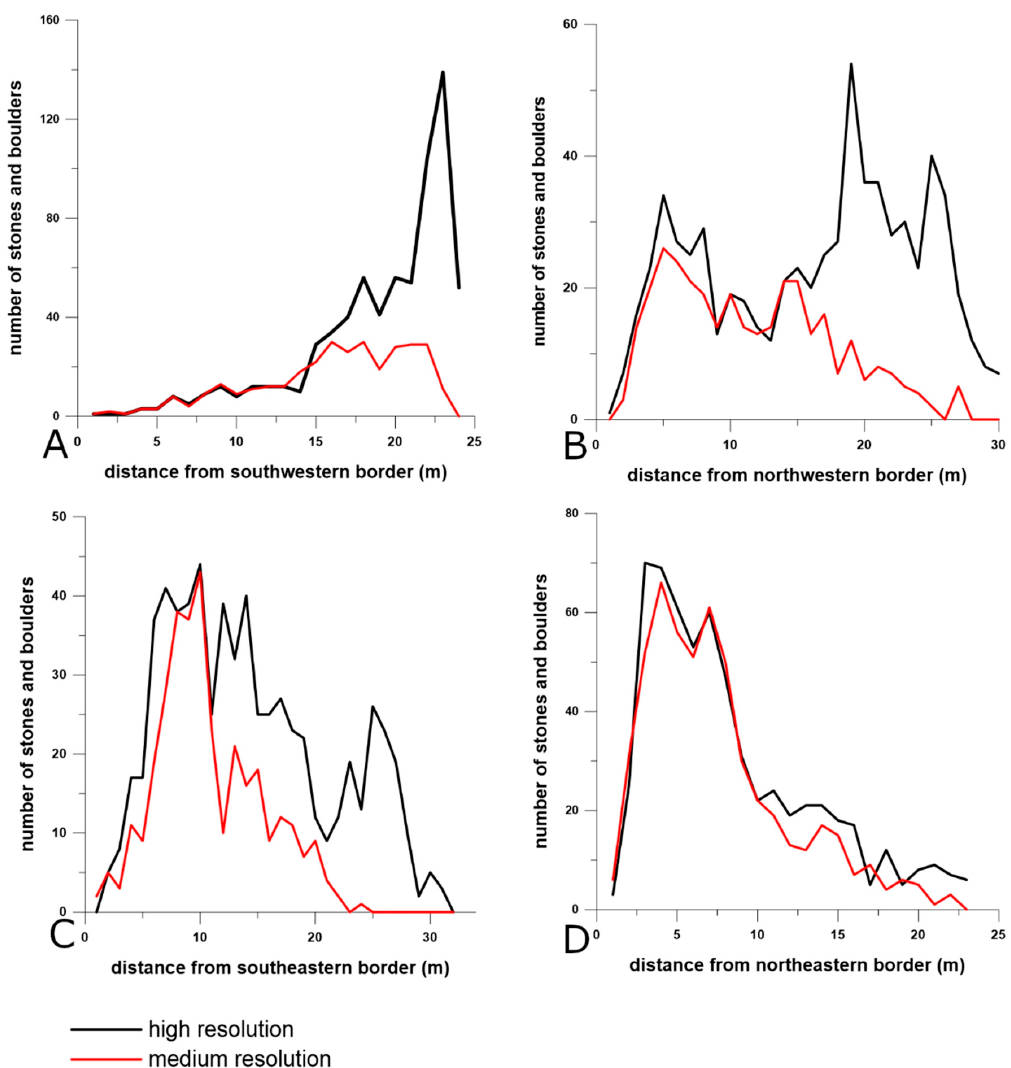
Figure 7. Numbers of boulders: for the high and medium resolution data related to the range distance from different directions. Black lines display the numbers of boulders collected from the high-resolution data and red lines display values derived from the medium resolution data.